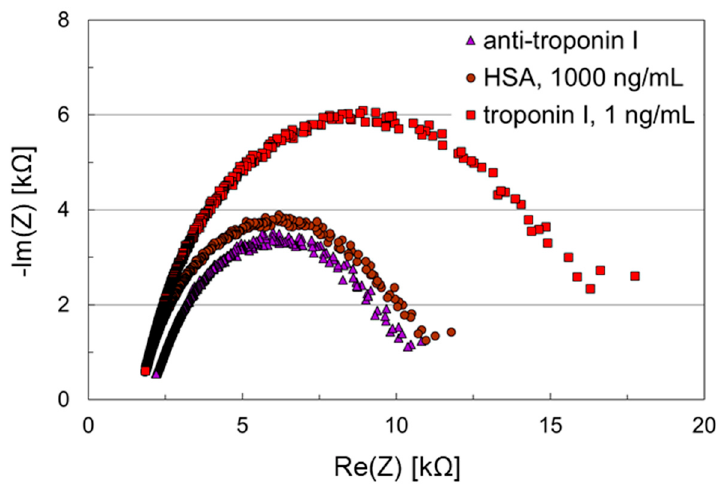
Figure 3. Nyquist plots of an impedance biosensor chip with no intermediary self-assembled mono- layer (SAM) for troponin I detection. Anti-troponin I was adsorbed on the working electrode, while the counter electrode remained uncoated. Samples containing human serum albumin (HSA), 1000 ng/mL, and troponin I, 1 ng/mL, were applied subsequently to the biosensor chip.